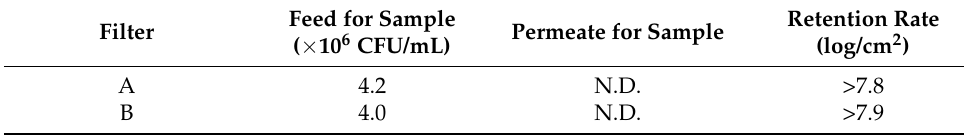
Table 3. Results of the bacterial challenge test.